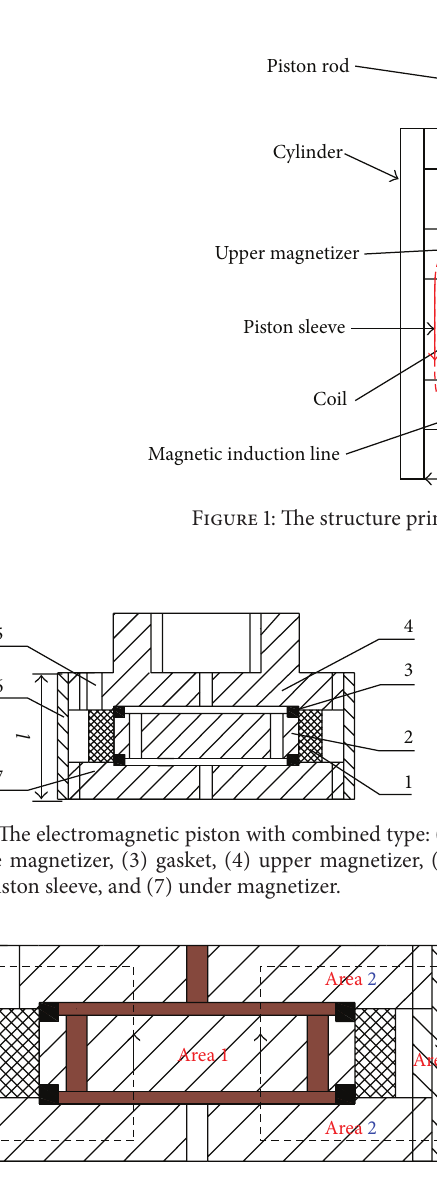
Figure 3: The structure of magnetic